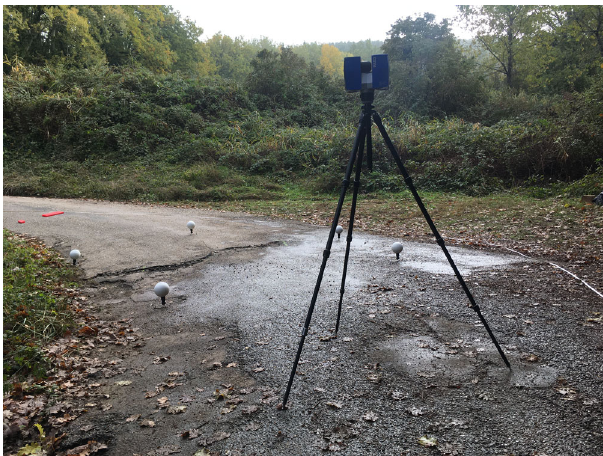
Fig. 1 This tiny scarp on the La Rouvière tar road was the fi rst evidence of Le Teil earthquake-related ground rupture uncovered by the fi eld team (2 days after the event). The equipment is a laser scanner to image accurately the offset.